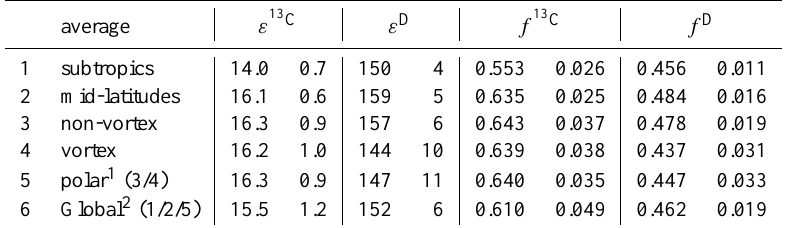
Table 6. Global mean dynamical factors f 13 C and f D inferred from the modelled sink partitioning and the averaged mean fractionation constants ε 13 C and ε D . The second column of values for a certain signature always gives the error. average ε 13 C ε D f 13 C f D 1 subtropics 14.0